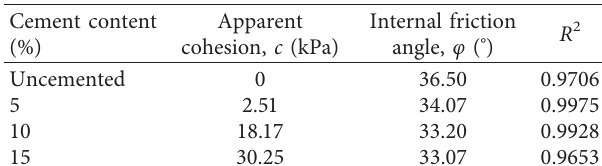
Figure 6: Coulomb shear strength envelops of calcareous sand with and without cement. Table 6: Shear strength indices of different types of calcareous sands.